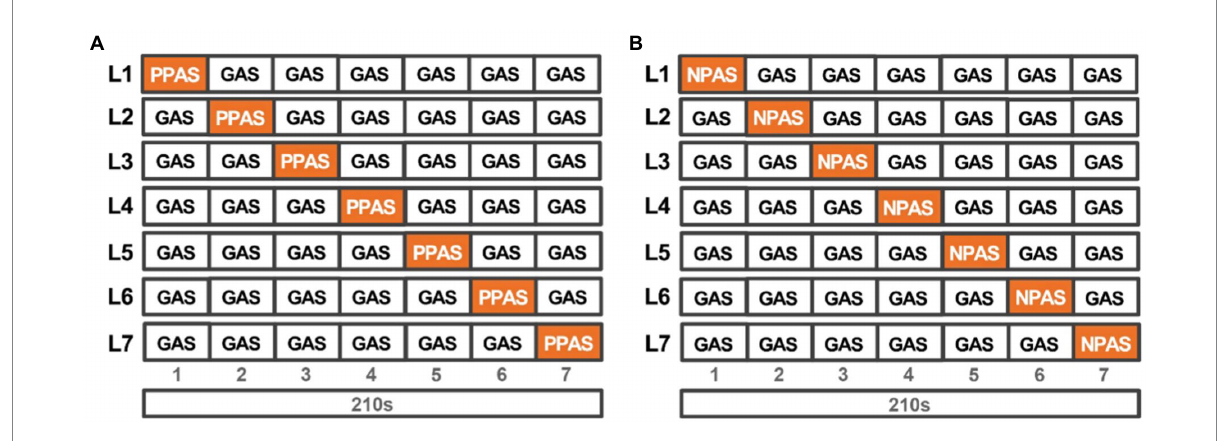
FIGURE 3 Composition of laboratory audiometric sound experience paths: (A) Composition of a PPAS-intervened laboratory audiometric sound experience paths; (B) Composition of a NPAS-intervened laboratory audiometric sound experience paths (PPAS, Positive peak assessment of soundscape segments, NPAS, Negative peak assessment of soundscape segments, GAS, general assessment of soundscape